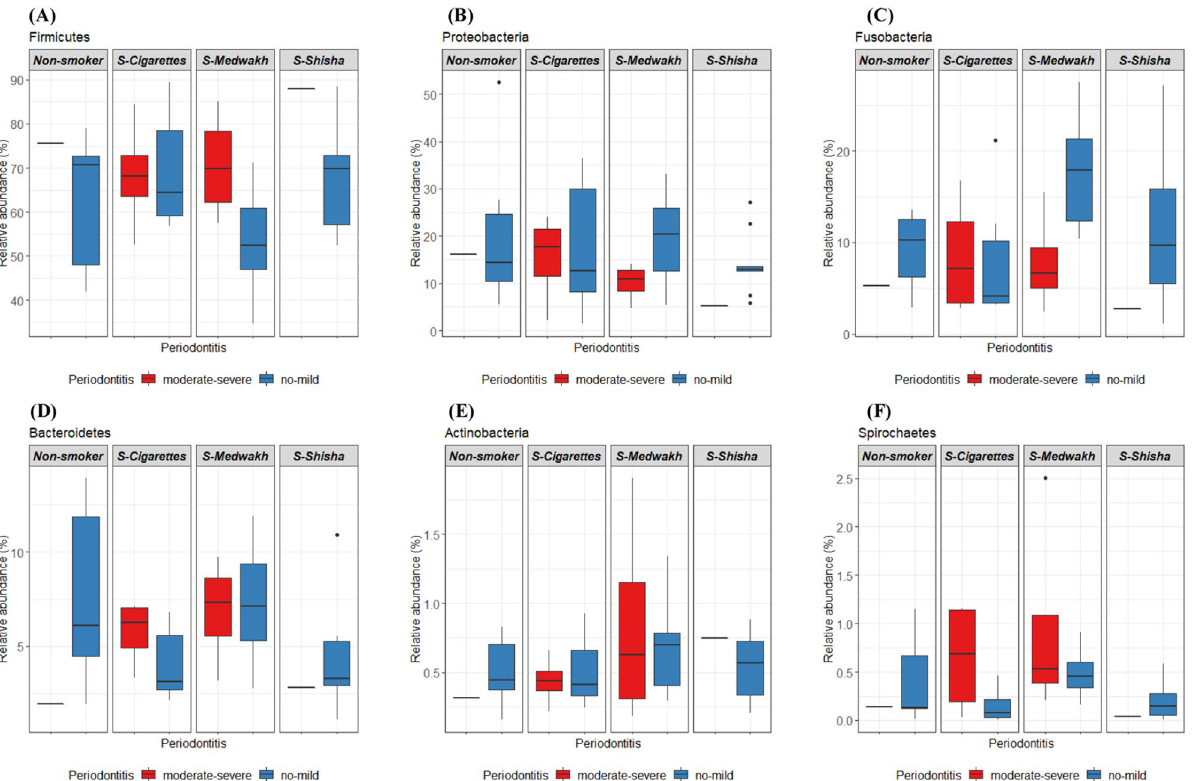
Figure 2. Comparison of the relative abundance (%) of the major phyla detected in subgingival plaque samples from non-smokers and smokers of cigarettes, medwakh and shisha with different stages of periodontal disease. Box plots show Q1-median-Q3 with range. Back dots are outlier